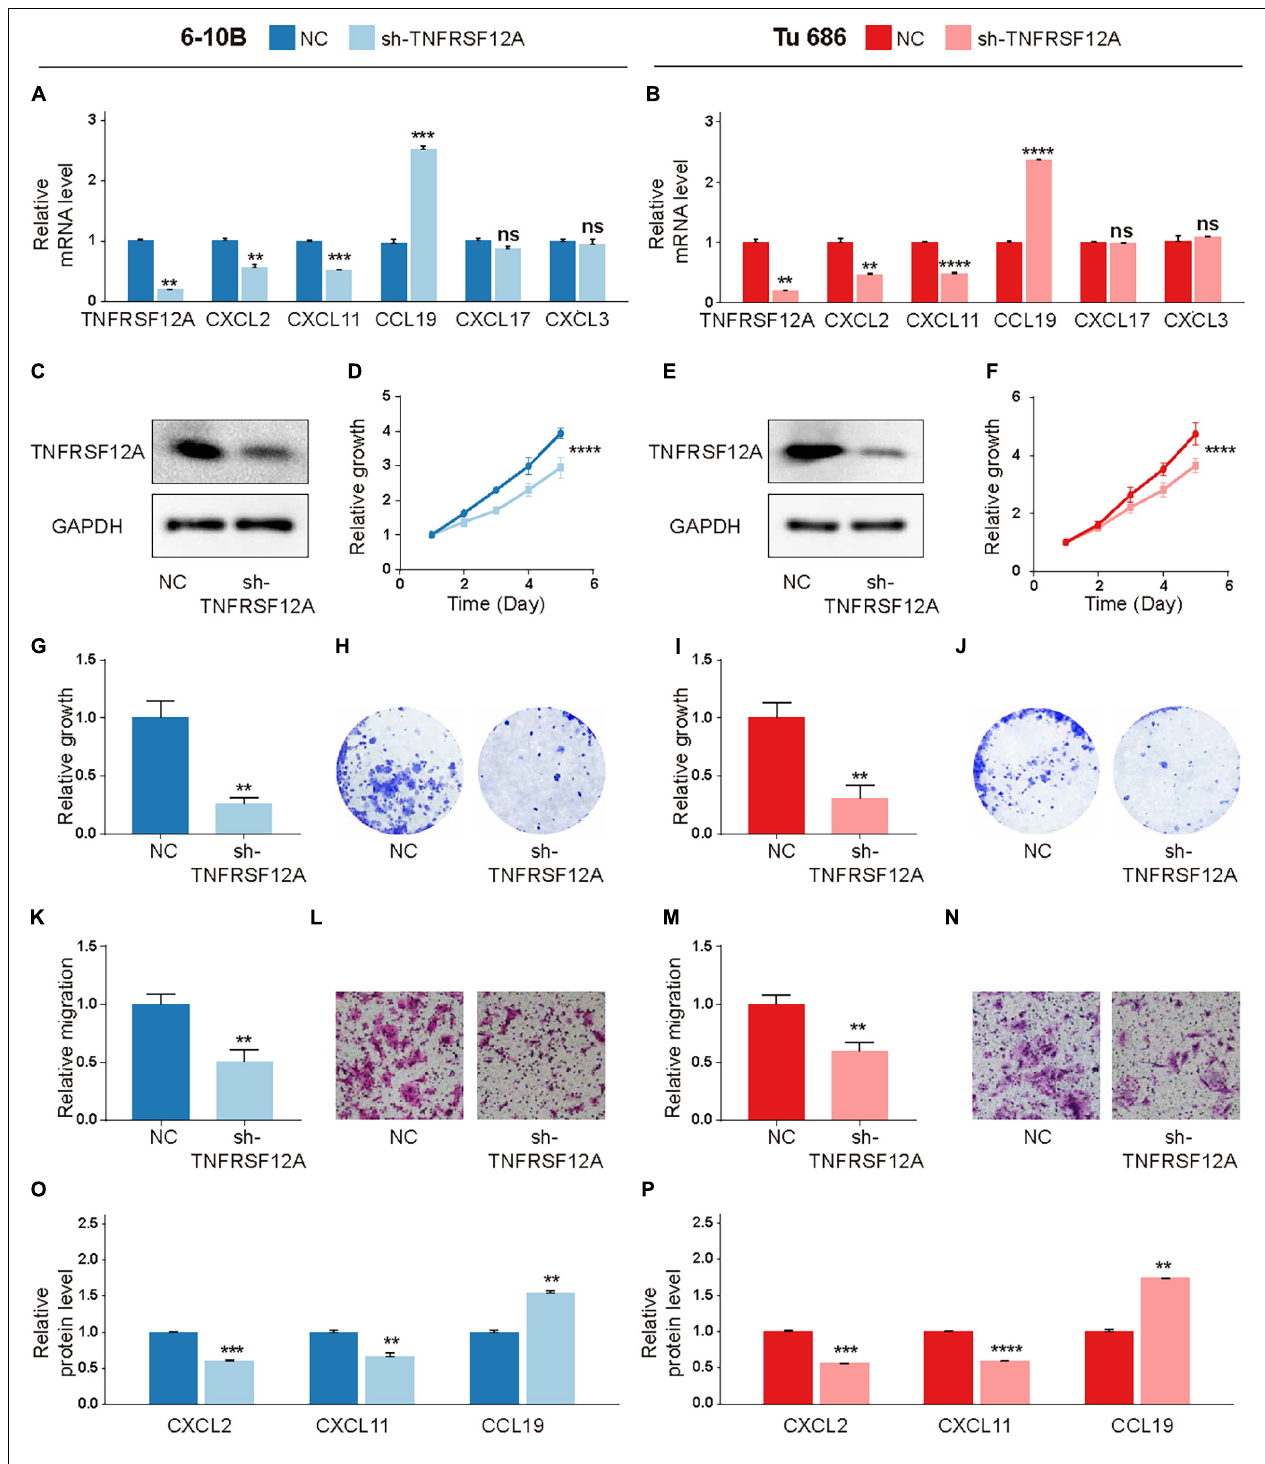
FIGURE 7 | TNFRSF12A was a tumor promoter in HNSCC. (A,B) Expression levels of TNFRSF12A, CXCL2, CXCL11, CCL19, CXCL3, and CXCL17 were detected via real-time PCR. (C,E) Transfection efficacies were validated by Western Blot. (D,F) Knockdown of TNFRSF12A in HNSCC cell lines inhibited cell proliferation was determined by CCK-8. (G,I) Clone formation assays revealed the effects of TNFRSF12A down-regulation on proliferation. (H,J) Representative images of clone formation. (K,M) Tranwell assays detected migration abilities in different groups. (L,N) Representative images of the transwell (Scale bar = 100 µ m). (O,P) ELISA exhibited that TNFRSF12A regulated expressions of CXCL2, CXCL11, and CCL19. n = 3/group for all assays; ns: not significant, ** p < 0.01, *** p < 0.001, **** p < 0.0001.